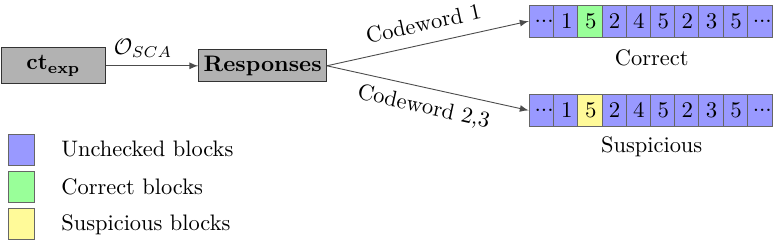
Figure 3: Procedure of checking the targeted